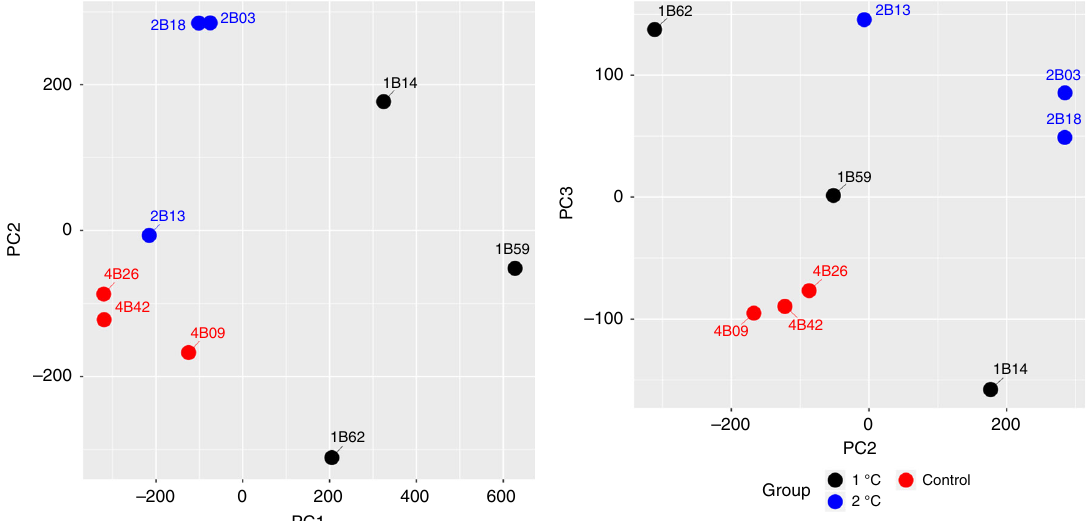
Fig. 1 PCA plot on normalised and fi ltered expression data of the different treatments. a First and second components of the PCA. b Second and third components of the PCA. Source data are provided as a Source Data fi